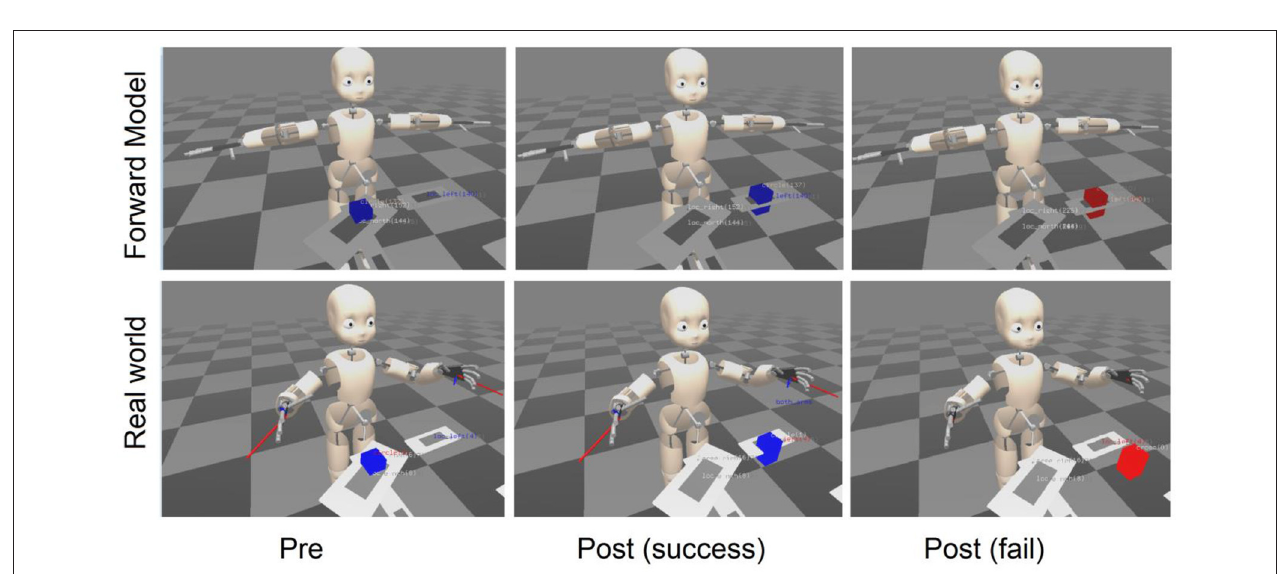
FIGURE 5 | Illustration of the forward model in the context of the motor control. The motor command is sent to the motor command system and to the internal model. Subsequent comparison allows the system to determine if the grasp was correctly executed (from Bubic et al., 2010).